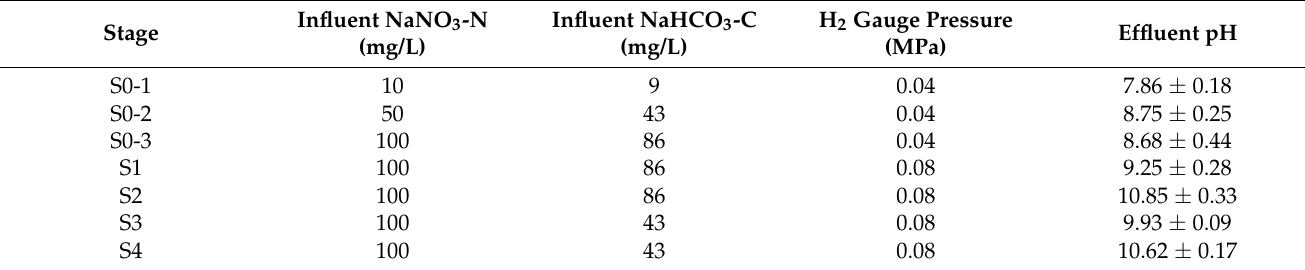
Table 1. Operational parameters for all stages and